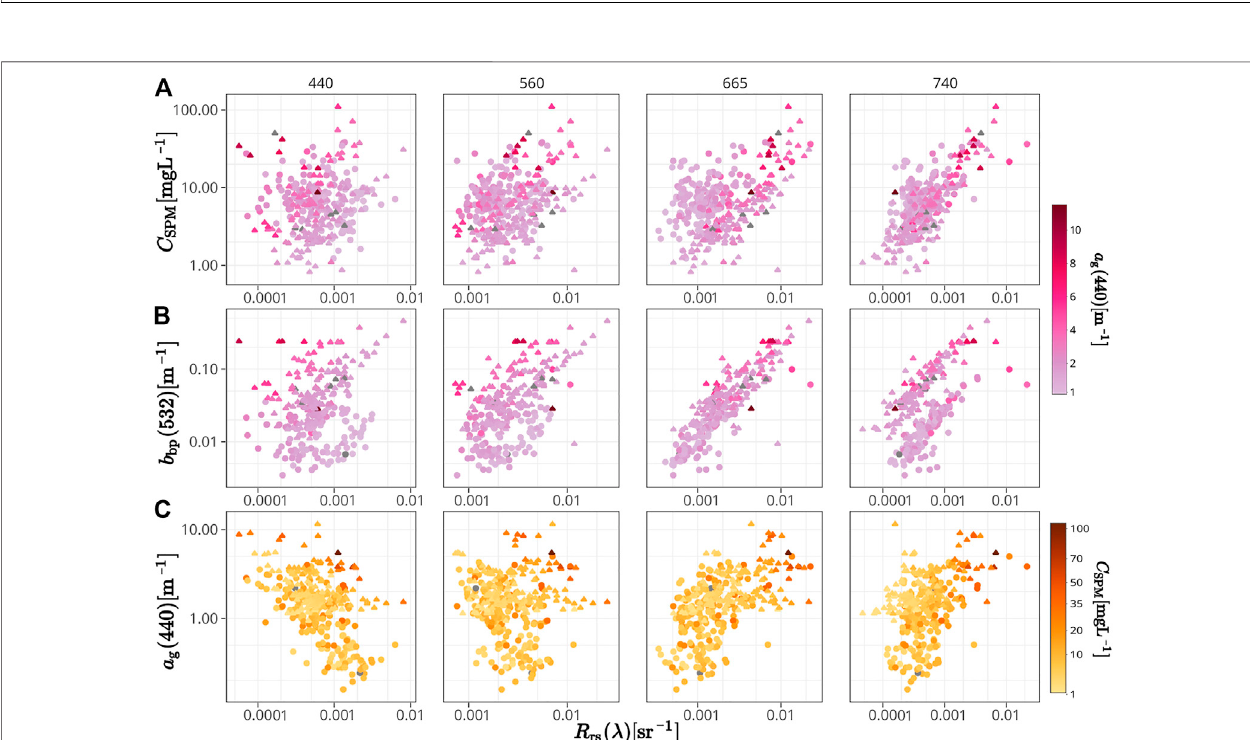
FIGURE 3 | Relation between R rs at 440, 560, 665, and 740 nm, and (A) C SPM , (B) b bp (532), and (C) a g (440). Plot (A) and (B) colors correspond to a g (440) to assess covariance patterns. Similarly,plot (C) colorscorrespondto C SPM insquarerootspace.Triangles andcirclesrepresent datafromJBandtheEGSL,respectively. Grey color represent missing